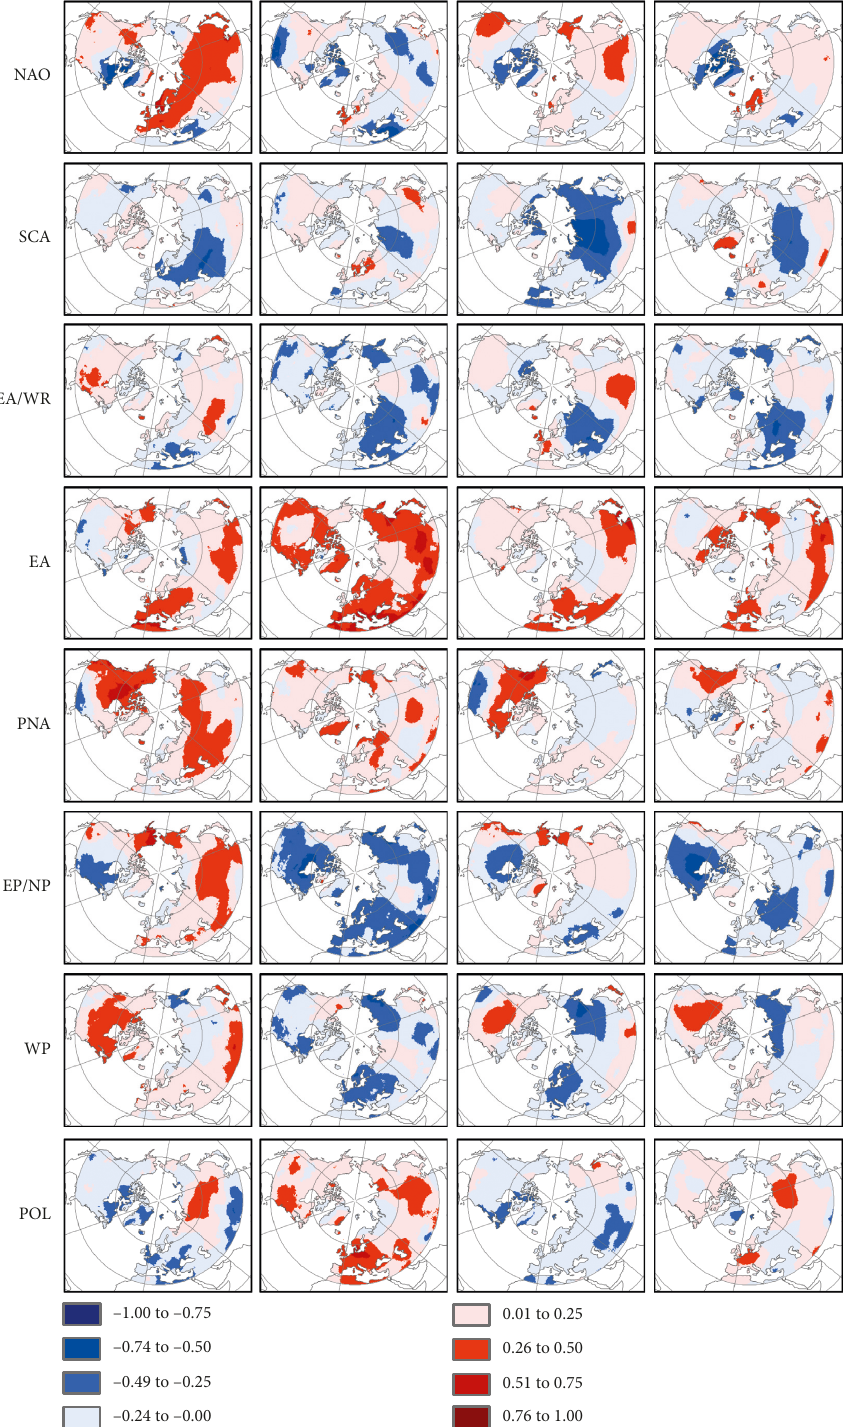
Figure 6: Spatial variation of correlation coefficients between indexes of the Northern Hemisphere teleconnection patterns and T T , and T in 1950–2015. Correlation coefficients higher than 0.25 and lower than − 0.25 are statistically significant ( p < 0 . apr oct